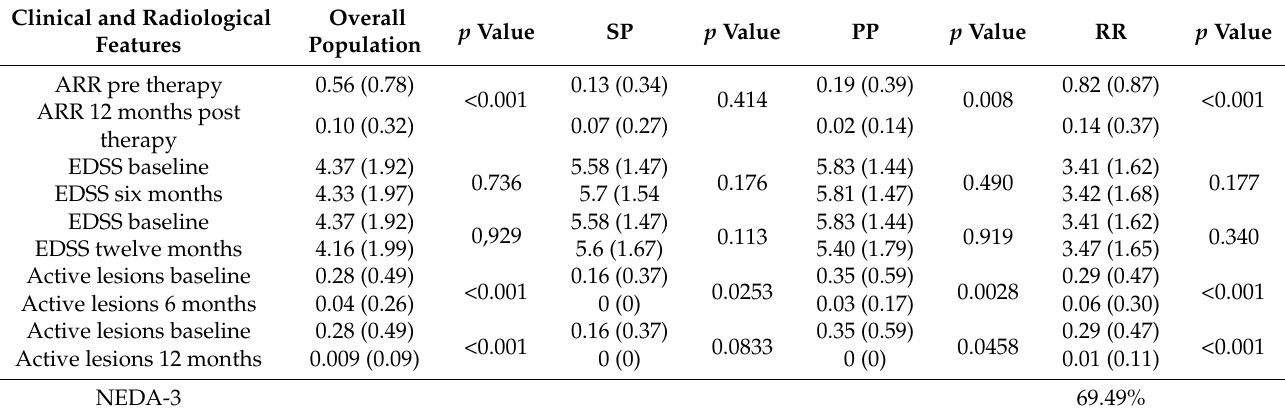
Table 2. Ocrelizumab effectiveness in overall patients, secondary progressive, primary progressive and relapsing remitting patients. Data are reported using mean ± standard deviation (sd). Clinical and